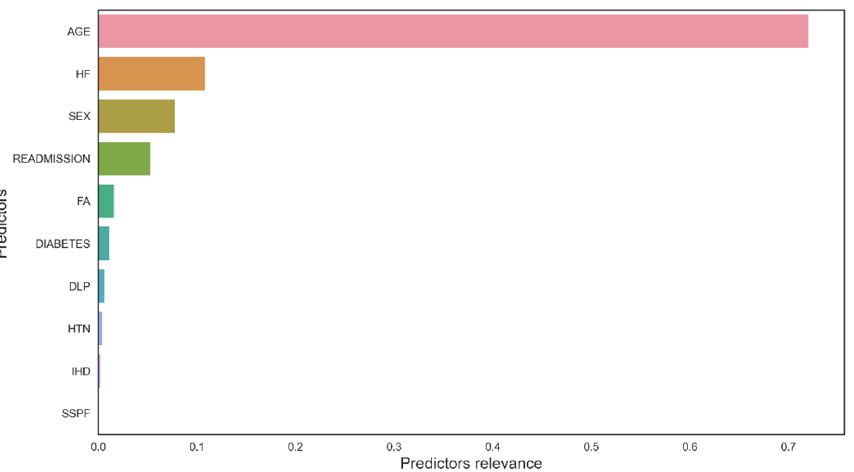
Figure 6. Random forests. Relevance of predictors for mortality. HF: heart failure; FA: atrial fibrillation; DLP: dyslipidaemia; HTN: arterial hypertension; IHD: ischaemic heart disease; SSPF: Symptoms suggestive of posterior fossa infarction.